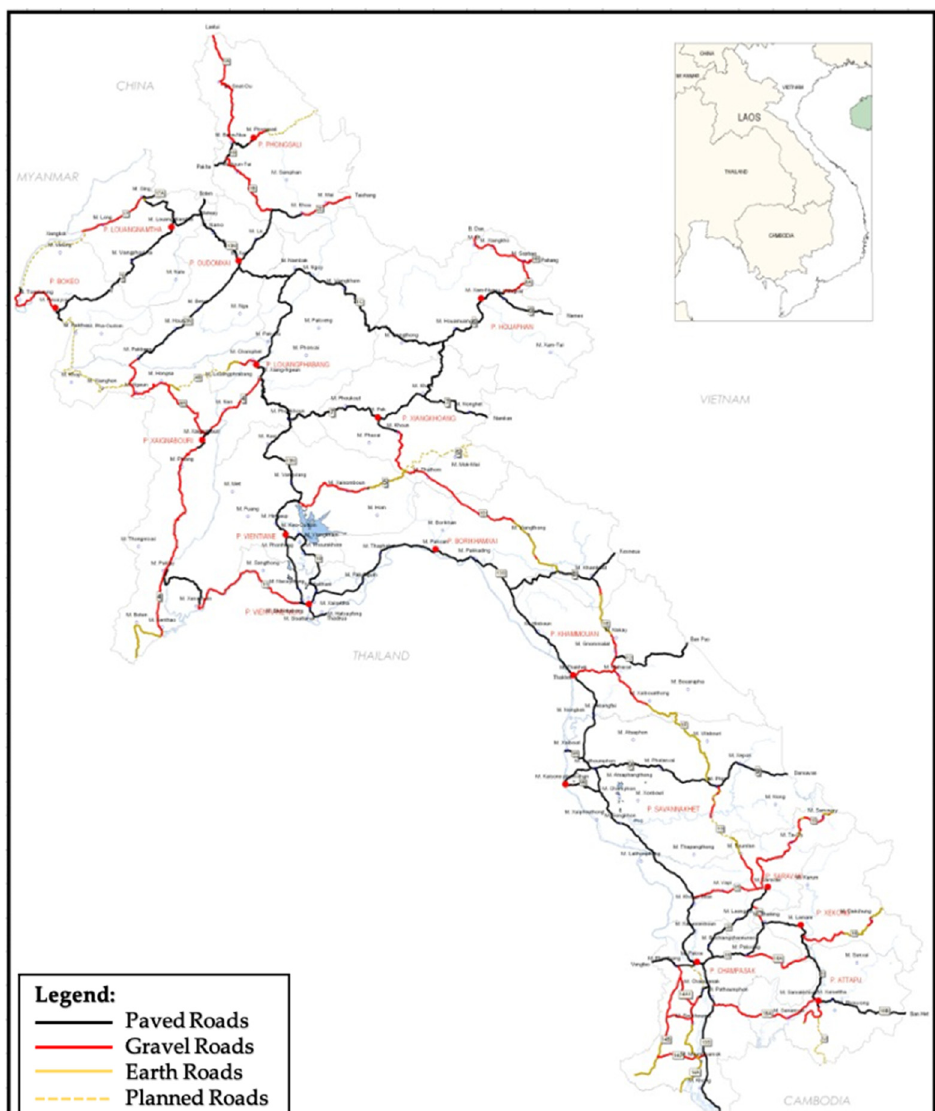
Figure 1. Laos NRs classification based on construction materials [33].